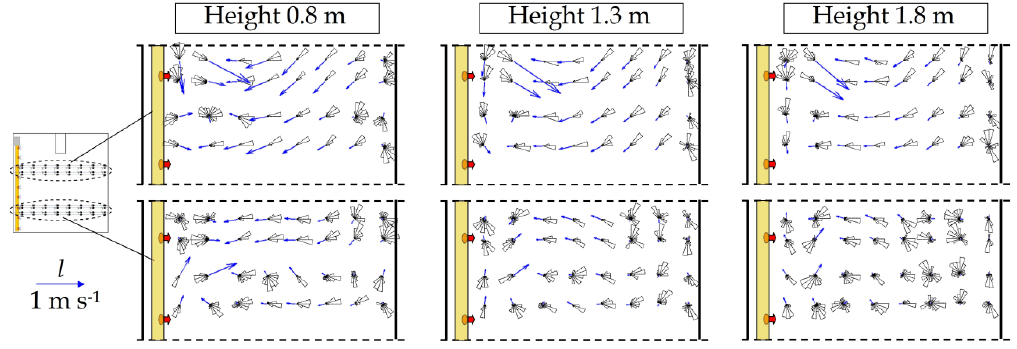
Figure 6. Two-dimensional resultants of air velocity in the XY ( l ) and polar plots of airflow direction in measurement test 2.